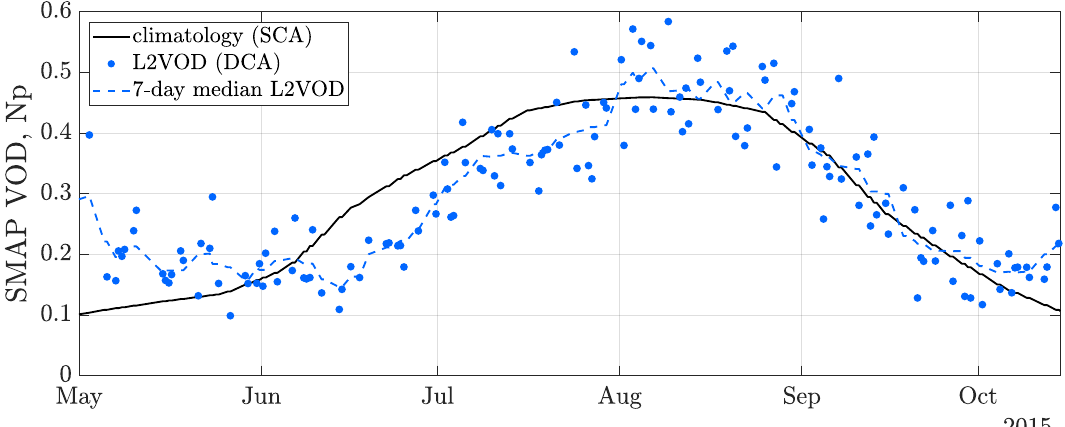
Figure 2. Timeseries of climatological vegetation optical depth (VOD) and retrieved L2VOD during 2015 for the South Fork EASE09 cell. The dashed line is the seven-day median value of L2VOD centered on each